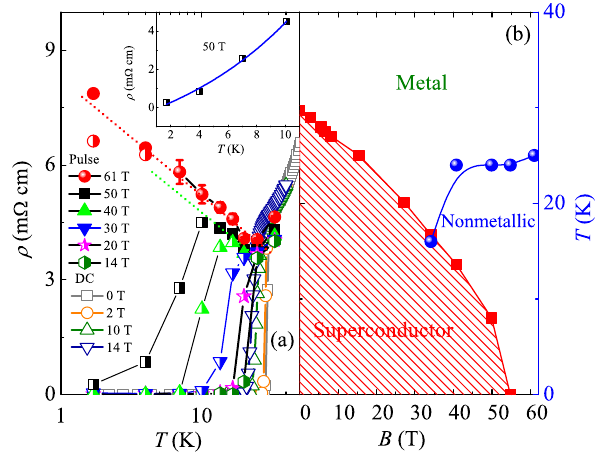
FIG. 4. (a) Temperature dependence of the in-plane resistivity in several DC (open symbols) and pulsed (filled symbols) magnetic fields for temperatures between 1.75 and 100 K. Pulsed-field data (filled symbols) near T c are consistent with results in DC and zero fields (open symbols). The two half-filled symbols for 61 T at 1.75 and 4 K denote the extrapolated values of the resistivity after complete suppression of the superconduc- tivity. The red and green dashed lines are the linear fitting result for the 61 T data and 50 T data when using the logarithmic scale, respectively. Inset: Resistivity of the mixed state in a 50-T field. The blue dotted line is an exponential fitting result (see text). (b) The schematic temperature-field phase diagram of K 0 Fe 1 Se 1 Te 0 . 70 . 46 . 85 . 15